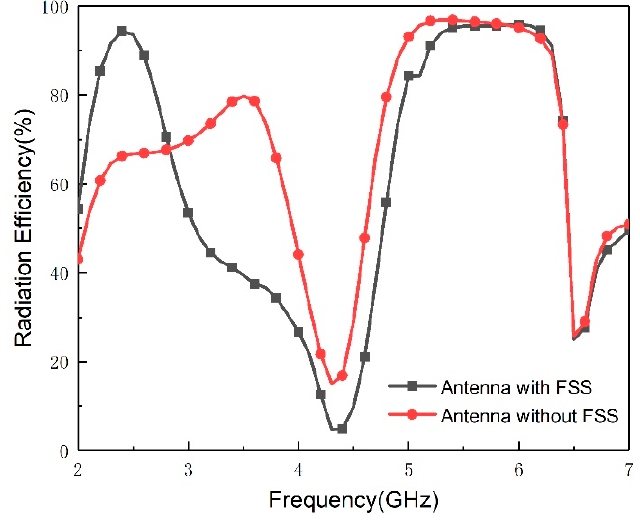
Figure 15. The simulated radiation efficiency of the antenna with and without an FSS.